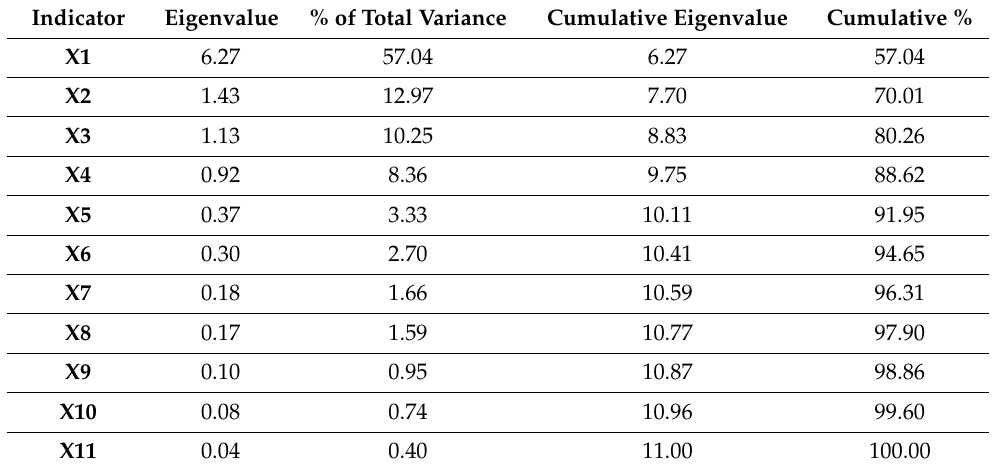
Table 5. Eigenvalues of correlation